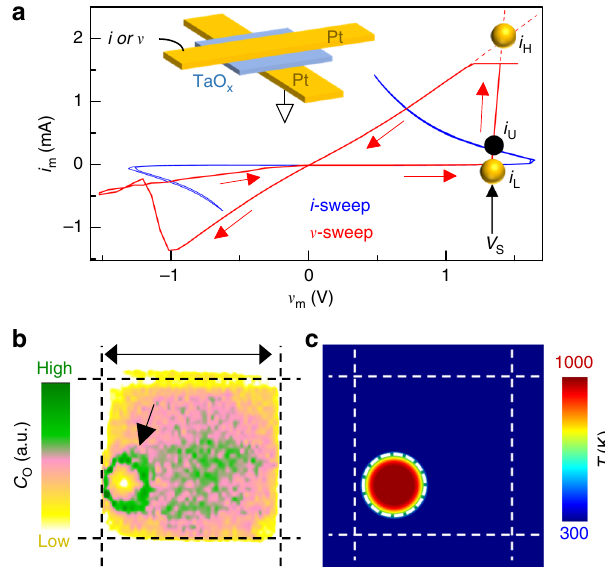
Fig. 2 Current-density-decomposition as a precursor to electroforming in memristors. a An i -sweep (blue) on a previously un-operated crosspoint tantalum oxide memristor clearly showing reversible current-controlled NDR. A v -sweep (red) following the i -sweep on the same device, revealing non-volatile switching. Positive v -sweep was applied fi rst, with the abrupt non-volatile switching occurring at a voltage value of V S . Inferred stable ( i H and i L ) and unstable ( i U ) current levels are marked on the experimental data. i H was extrapolated from the total electrode resistance since this is the only internal current compliance capable of arresting transient current overshoots. ( a , inset) schematic of the crosspoint device structure. b Lateral oxygen concentration ( C O ) map of a different but nominally identical device to that shown in a after several non-volatile switching events, obtained by transmission synchrotron x-ray spectromicroscopy. The ring-like feature (indicated by a black arrow) is caused by a radial oxygen concentration gradient. Dashed lines mark the edges of the electrodes. c A simulated temperature ( T ) pro fi le for a decomposed current density calculated from the measured current/voltage levels during operation, with a common scale displayed in c . The common scale bar in b is 2 µ m. Additional analysis shown in Supplementary Fig.